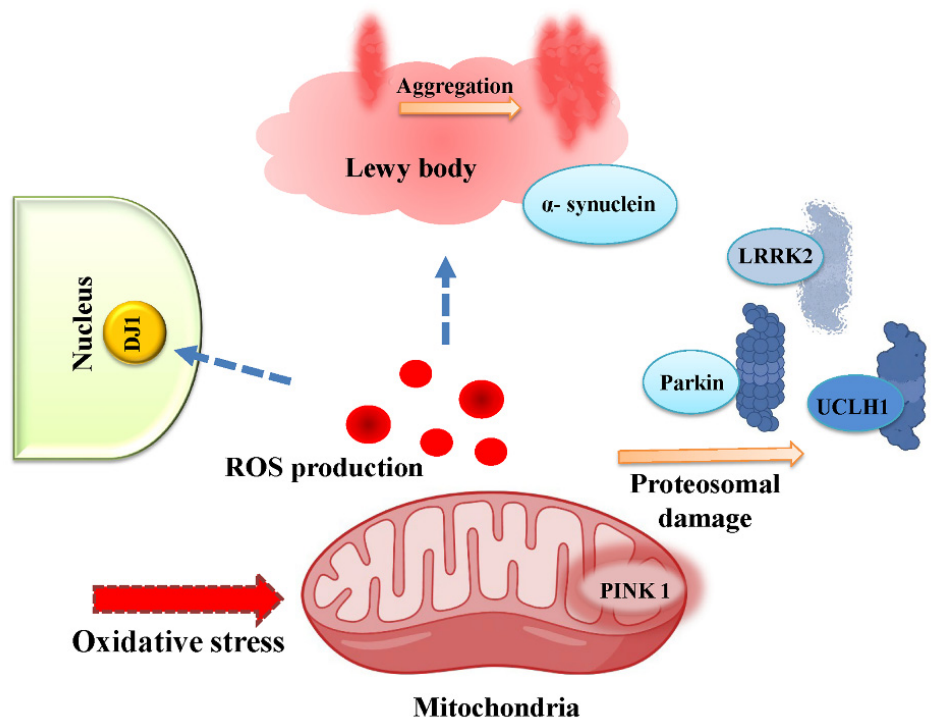
Figure 5. Familial PD genes link mitochondrial dysfunction and ROS production to PD pathology. Pink1 is a mitochondrial serine/threonine protein kinase that promotes mitophagy in depolarized mitochondria. PINK1 mutation affects mitochondrial respiration along with DA neuron loss and Lewy pathology. α -synuclein deposition in neurons or mitochondria and loss of parkin function increases oxidative stress, alters mitochondrial membrane potential, complex I function and mitochondrial morphology. DJ-1 is involved in response to oxidative stress and may be neuroprotective. Mutations in DJ-1 increase ROS production, accumulation of dysfunctional mitochondria and loss of membrane potential [69]. Mutations in the LRRK2 gene, a common cause of familial and sporadic PD affect mitochondrial dynamics, trafficking and degradation via autophagy [72].